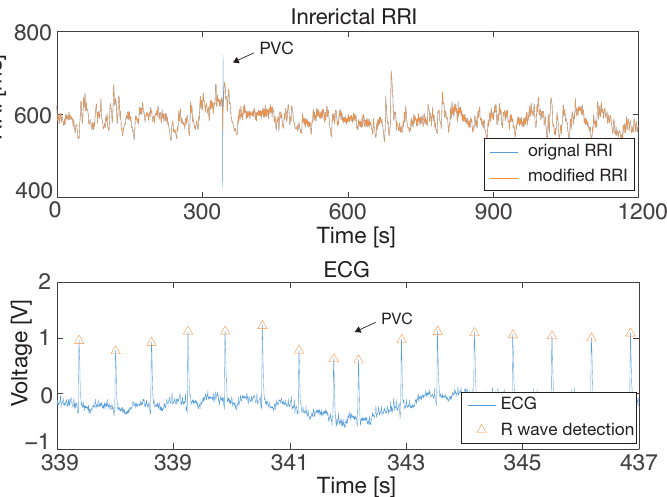
Figure 14. An interictal episode collected from an epileptic patient: RRI data with PVC ( top ) and the ECG data enlarged around the PVC ( bottom ). The arrow symbol denotes the PVC